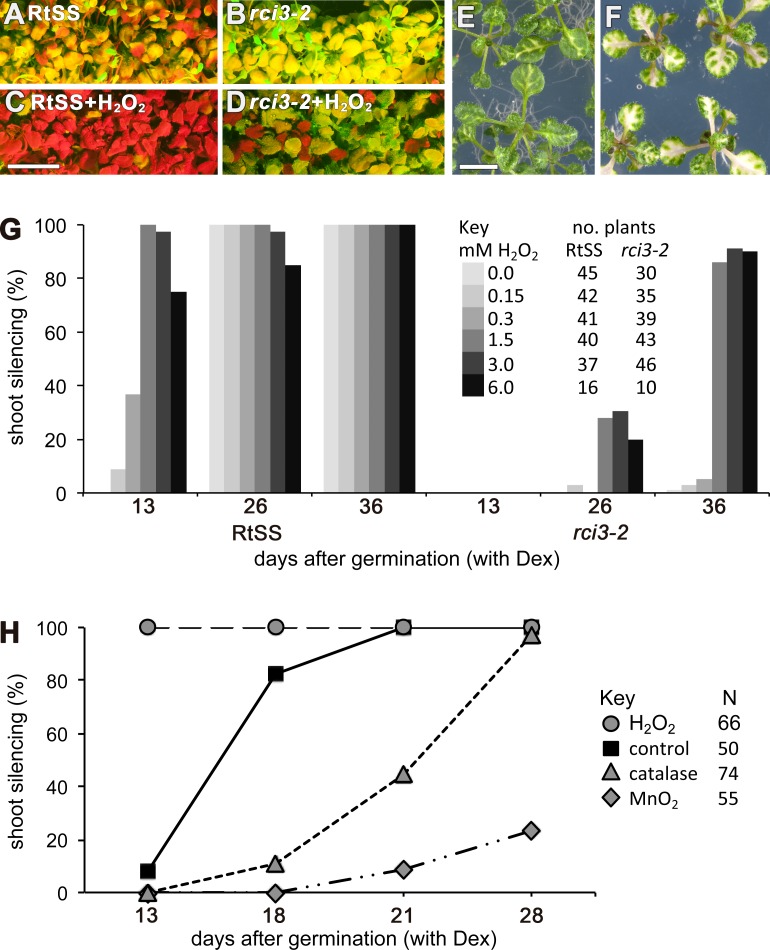
Effects of H2O2 or its breakdown catalysts on silencing in RtSS or rci3-2.(A) RtSS and (B) rci3-2 plants grown for 26 d on Dex medium only. (C) RtSS and (D) rci3-2 plants grown on medium containing H2O2 for 26 d after Dex-induction of silencing. (E) AtSuc2:PDS plants on MS medium. (F) AtSuc2:PDS plants grown on 1.5 mM H2O2 showed enhanced spread of silencing. (G) Effect of different concentrations of H2O2 on the percentage of shoots showing silencing in Dex-induced RtSS and rci3-2 plants. (H) H2O2 accelerated, and blocking H2O2 with catalase or MnO2 slowed, the percentage of shoots showing silencing in Dex-induced RtSS plants. N, number of plants.